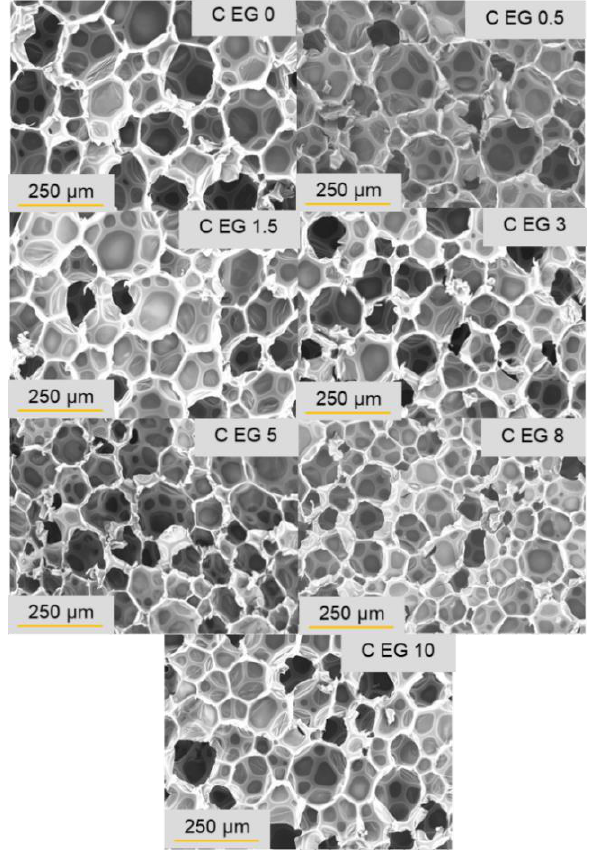
Figure 8. Scanning Electron Microscopy (SEM) of carvone-based PU with an increasing amount of